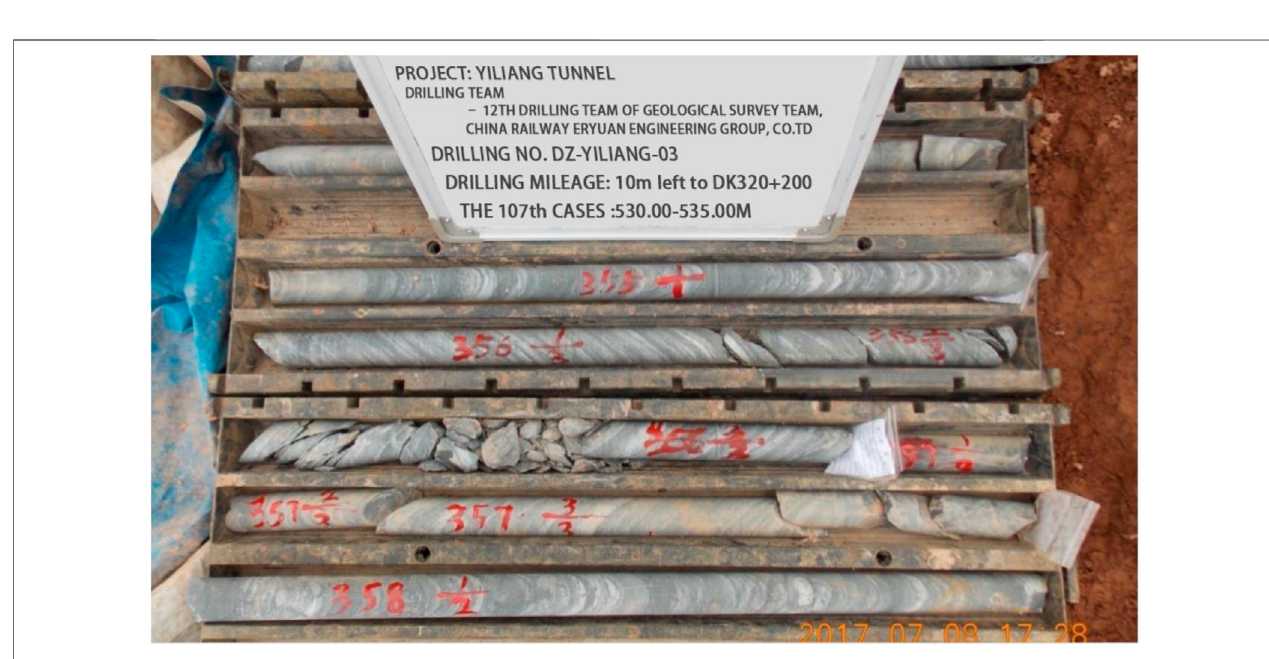
FIGURE 4 | Marlstones in the S2d